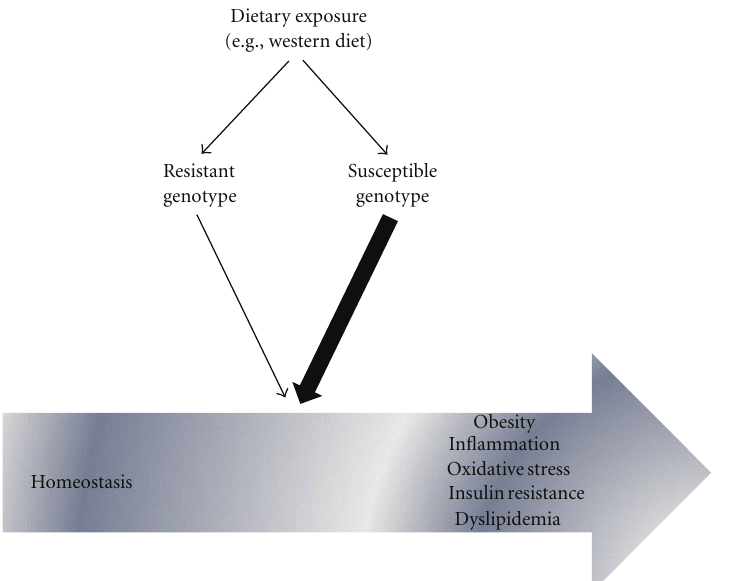
Figure 1: The association of gene variants with di ff erential responses to diet and its impact on the shift between homeostasis and metabolic/immune